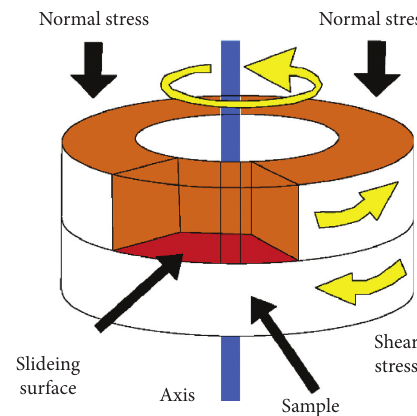
Figure 2: Schematic diagram of ring shear